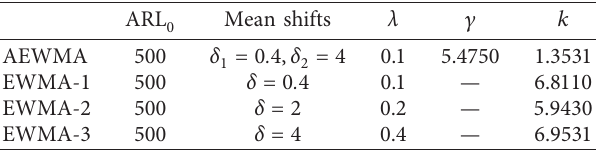
Table 4: Optimization results of AEWMA and EWMA control charts for abnormal state